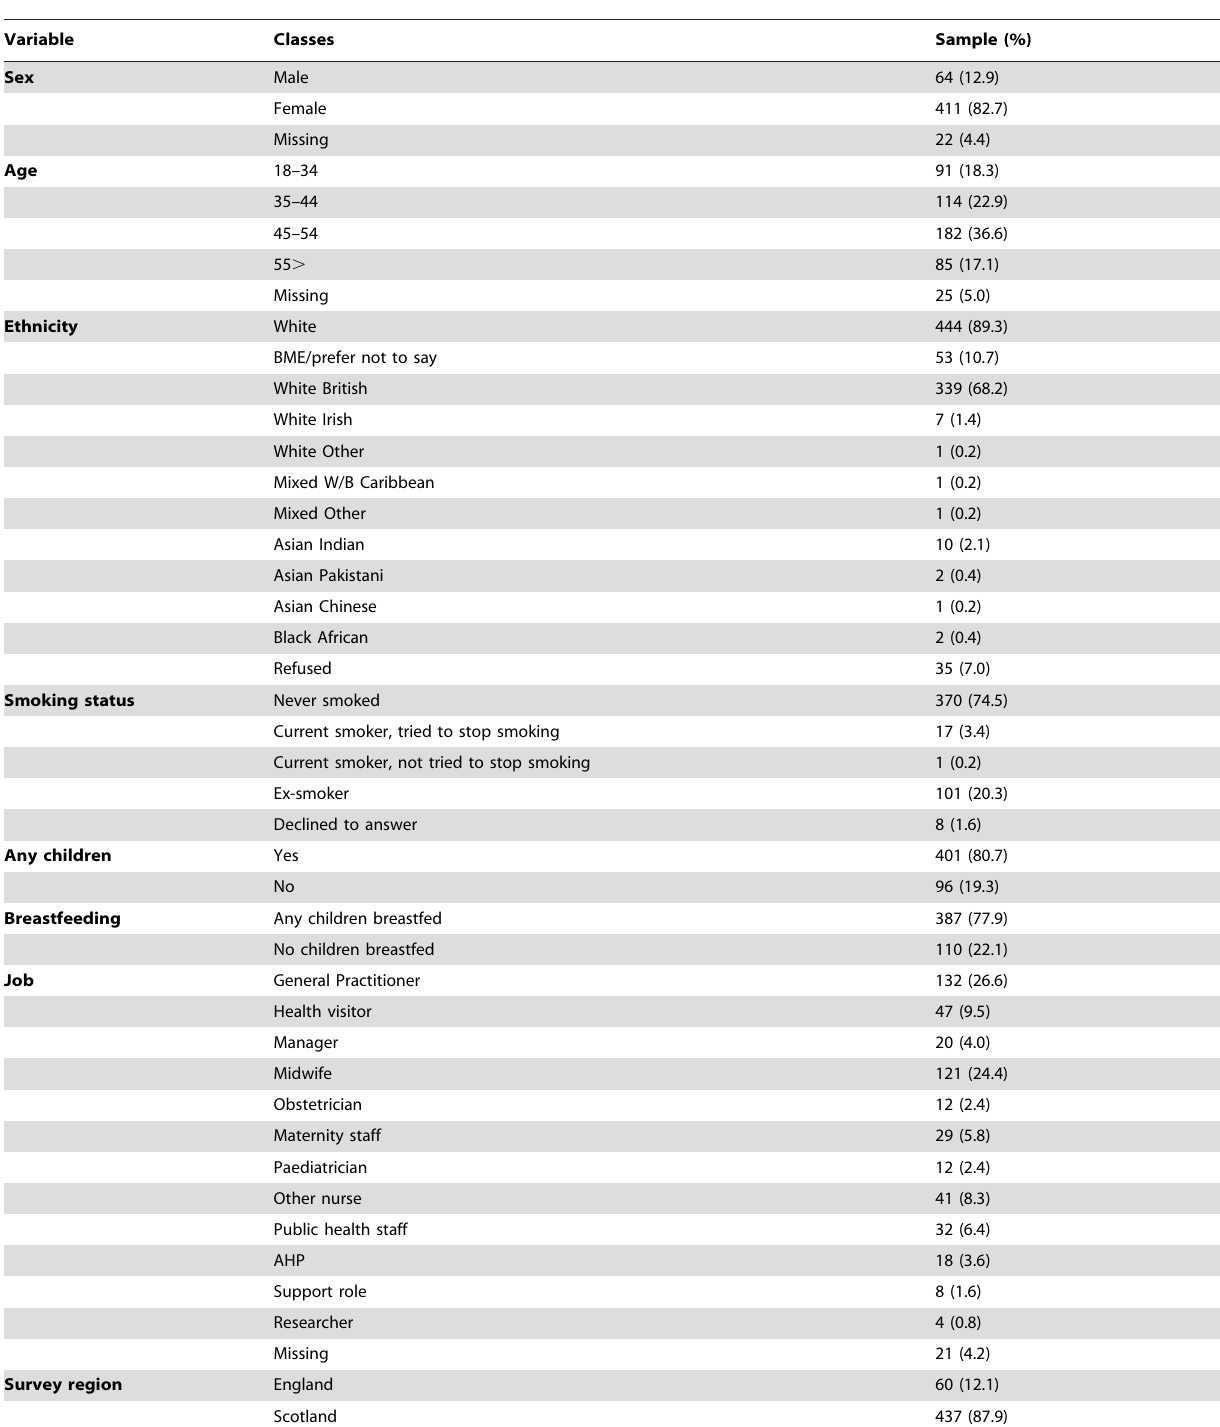
Table 9. Characteristics of the maternity and early years health professional sample (n=